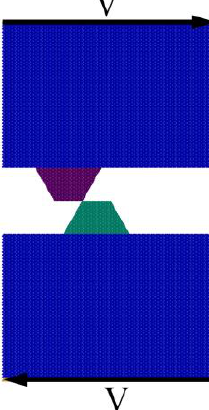
Fig. 1. The structure of the model sample and the scheme of